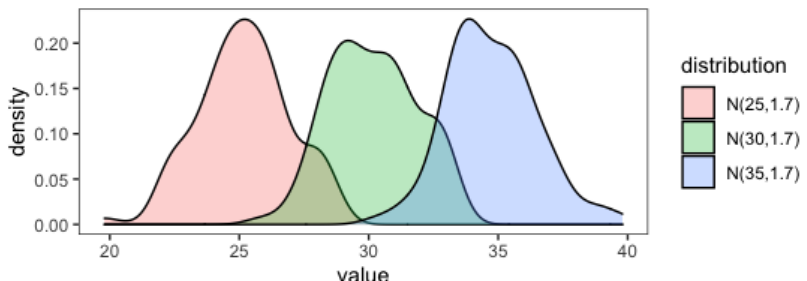
Figure 2. A density plot for the previous distribution and the new distribution. Take the 30th trial as an example. In the gradually changed block, the previous distribution N (30,1.7) (the green density plot) and the new distribution N (35,1.7) (the blue density plot) were highly overlapped. Thus, the change in the target value was relatively smooth. In the abruptly changed block, the previous distribution N (25,1.7) (the pink density plot) and the new distribution N (35,1.7) (the blue density plot) were slightly overlapped; thus, the change of the target value was abrupt and substantial.